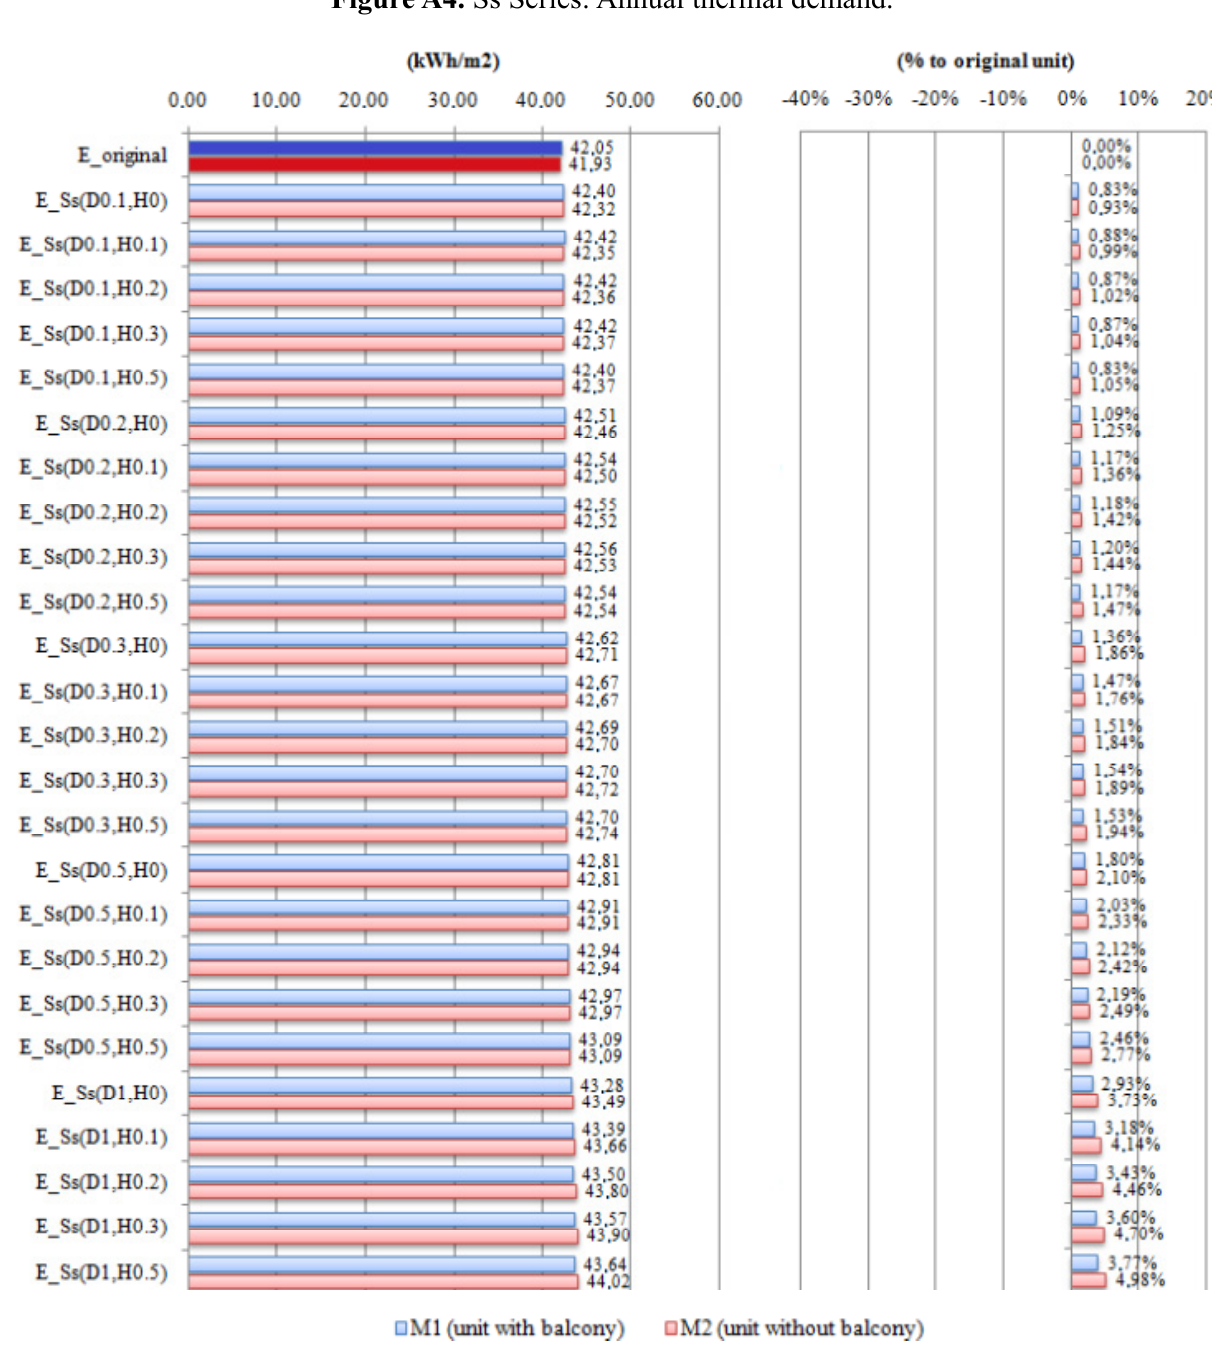
Figure A4. Ss Series: Annual thermal